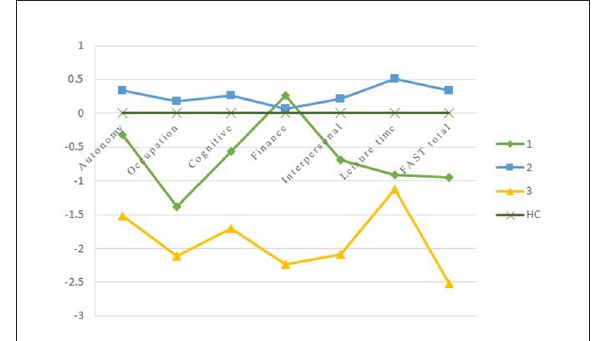
FIGURE2 The Z-scores of the FAST comparing BD clusters with HCs. The Y-axis depicts z-scores with a Mean of 0 and SD of 1. HC = healthy controls; cluster 1 = moderate functioning; cluster 2 = good functioning; cluster 3 = lower